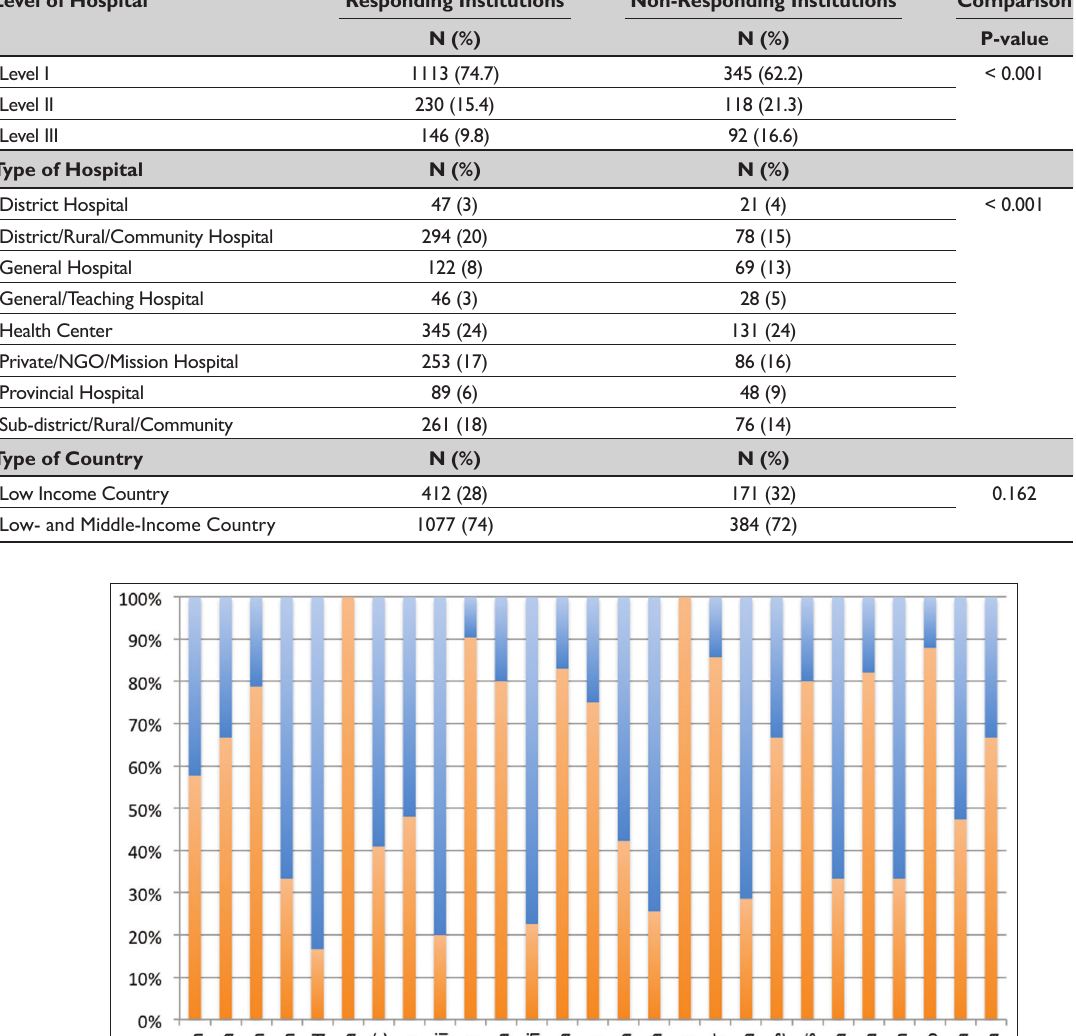
Table 1: Comparison Between Responding and Non-responding Institutions Level of